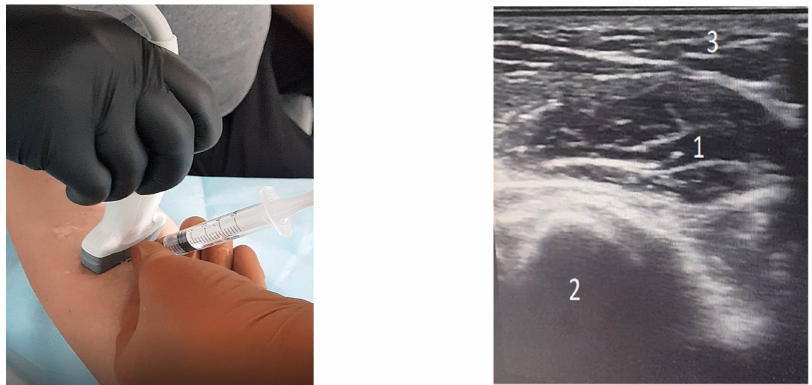
Figure 1. Incobotulinumtoxin A injection of the right upper limb—pronator teres muscle. The ultra- sound image shows the pronator teres muscle (1), to be injected, and adjacent structure: ulna bone (2) and subcutaneous tissue (3). On the gray scale, the muscle appears more hypo echoic, bordered by hyper echoic lines, representing the muscular fascia. Ulna bone—only the edge that appears intense hyper echoic-white is visualized, the rest of the bone structure not being visible by ultrasound and the shadow cone appears-black-under the bone. The subcutaneous tissue is hypo echoic and located on the surface, above the